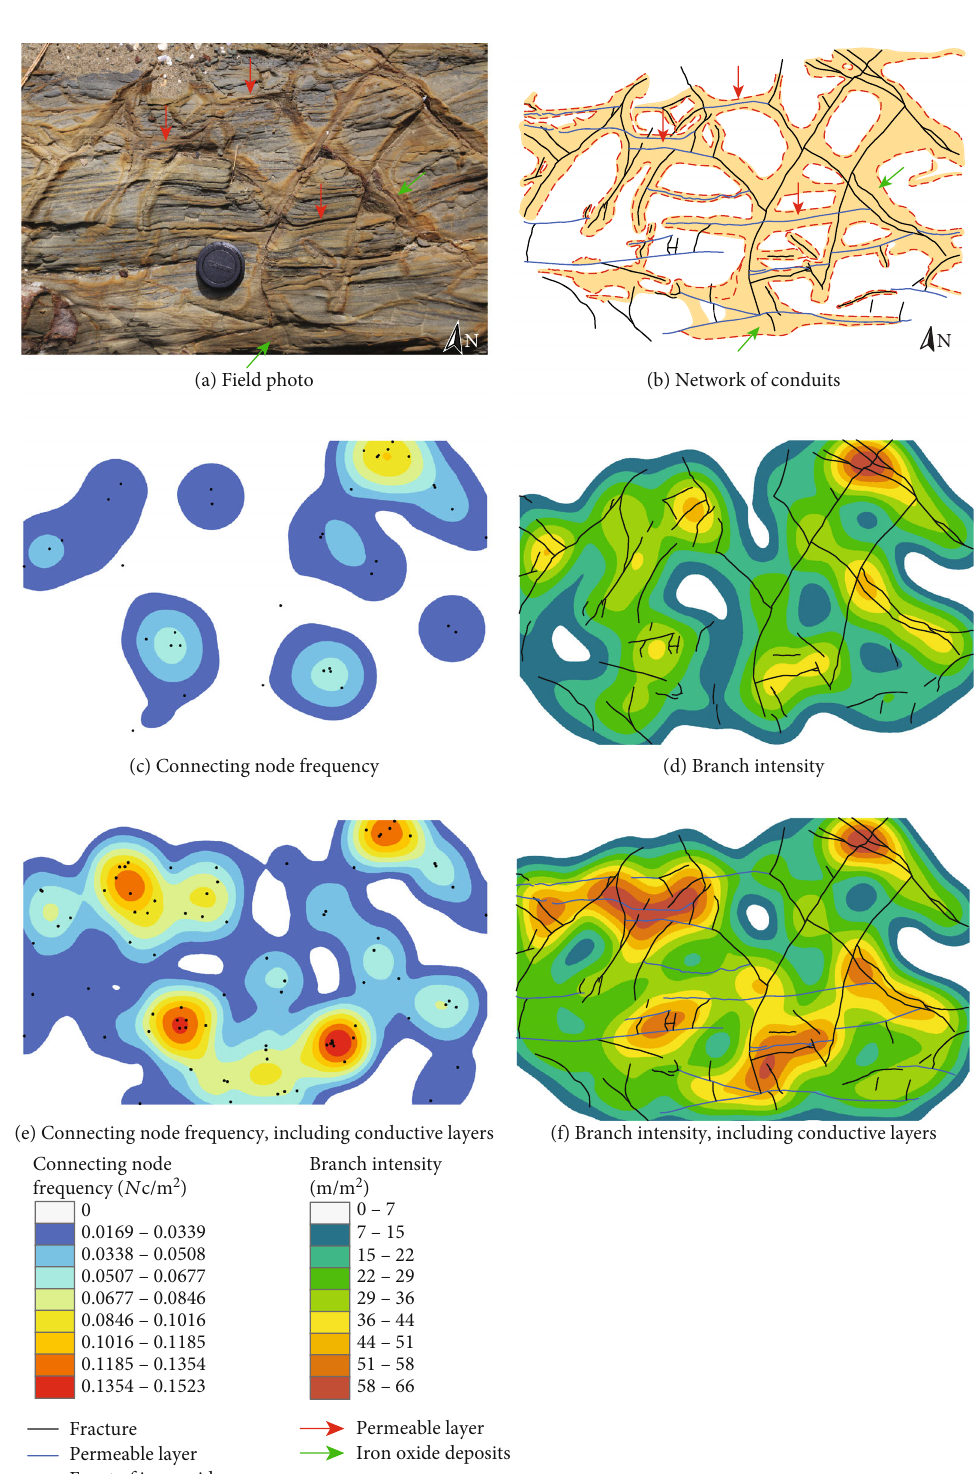
Figure 12: (a) Field photo of a simple cross-cutting fracture network from Hokianga, New Zealand, interacting with highly permeable layers in the host rock. (b) A digitized fracture network (black lines) and highly permeable layers (blue lines), surrounded by iron oxide precipitates (orange). Red arrows point to examples of where more permeable layers work as conduits between fractures. (c) Map of the connecting node frequency of the studied part of the fracture network. (d) Map of the branch intensity of the studied part of the fracture network. (e) Map showing the connecting node frequency, including connection points between fractures and highly permeable layers, forming a hybrid network. (f) Branch intensity of the studied network, including the highly permeable layers in the host rock forming a hybrid